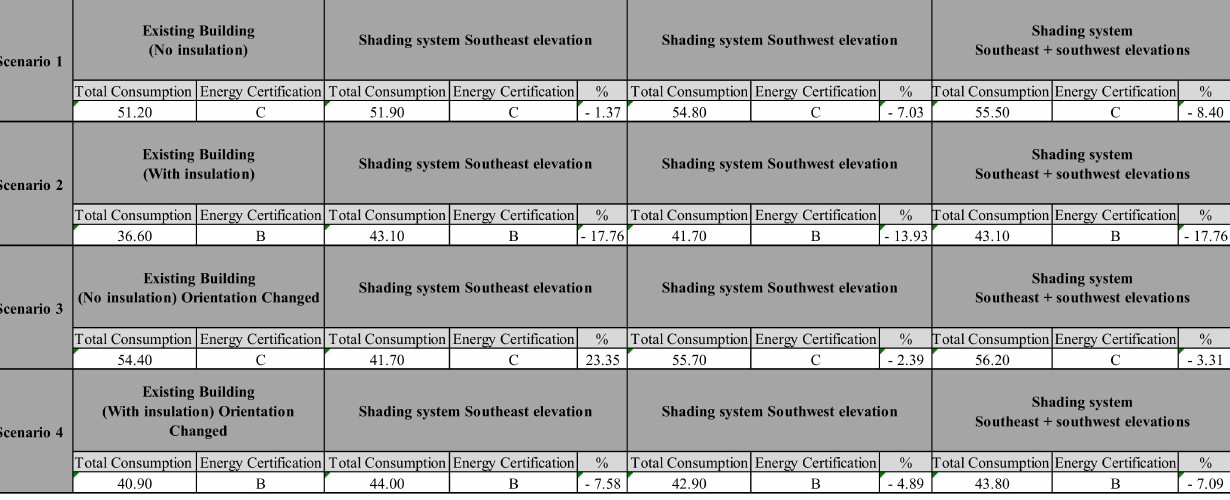
Figure 10. Calculation of the final energy consumption with HULC (kWh/m 2 year) and the improvement (%) of the shading